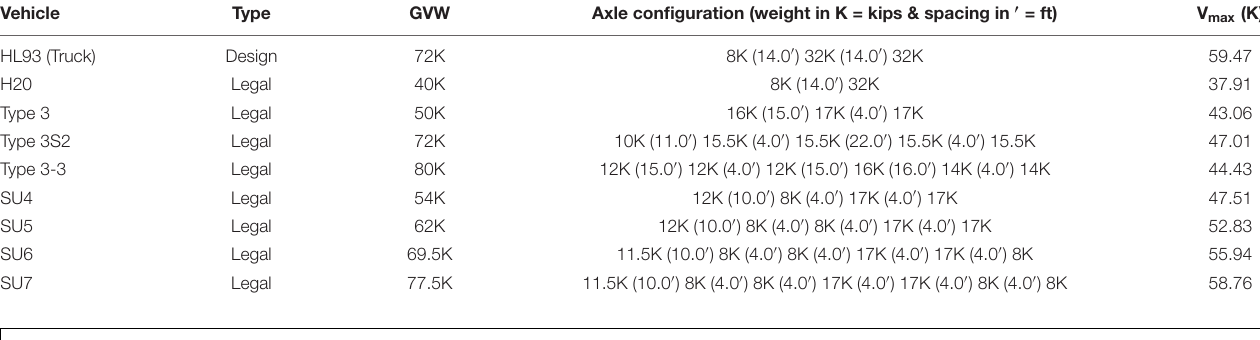
TABLE 1 | Maximum shear force (V max ) in a 53 (cid:48) -71/2 (cid:48)(cid:48) simple span due to different rating vehicles. Vehicle Type GVW Axle configuration (weight in K = kips & spacing in (cid:48) = ft)